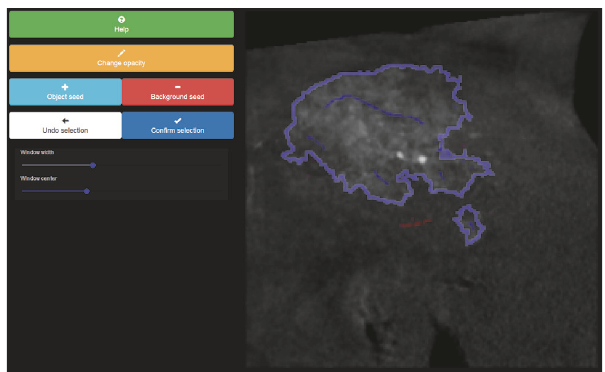
Figure 3: Guided segmentation prototype user interface. The current segmentation displayed on the upper left can be improved by choosing one of the four segmentation alternatives displayed on the right. The user is expected to choose the upper-right option in this configuration, due to the two new seeds’ matching background and foreground